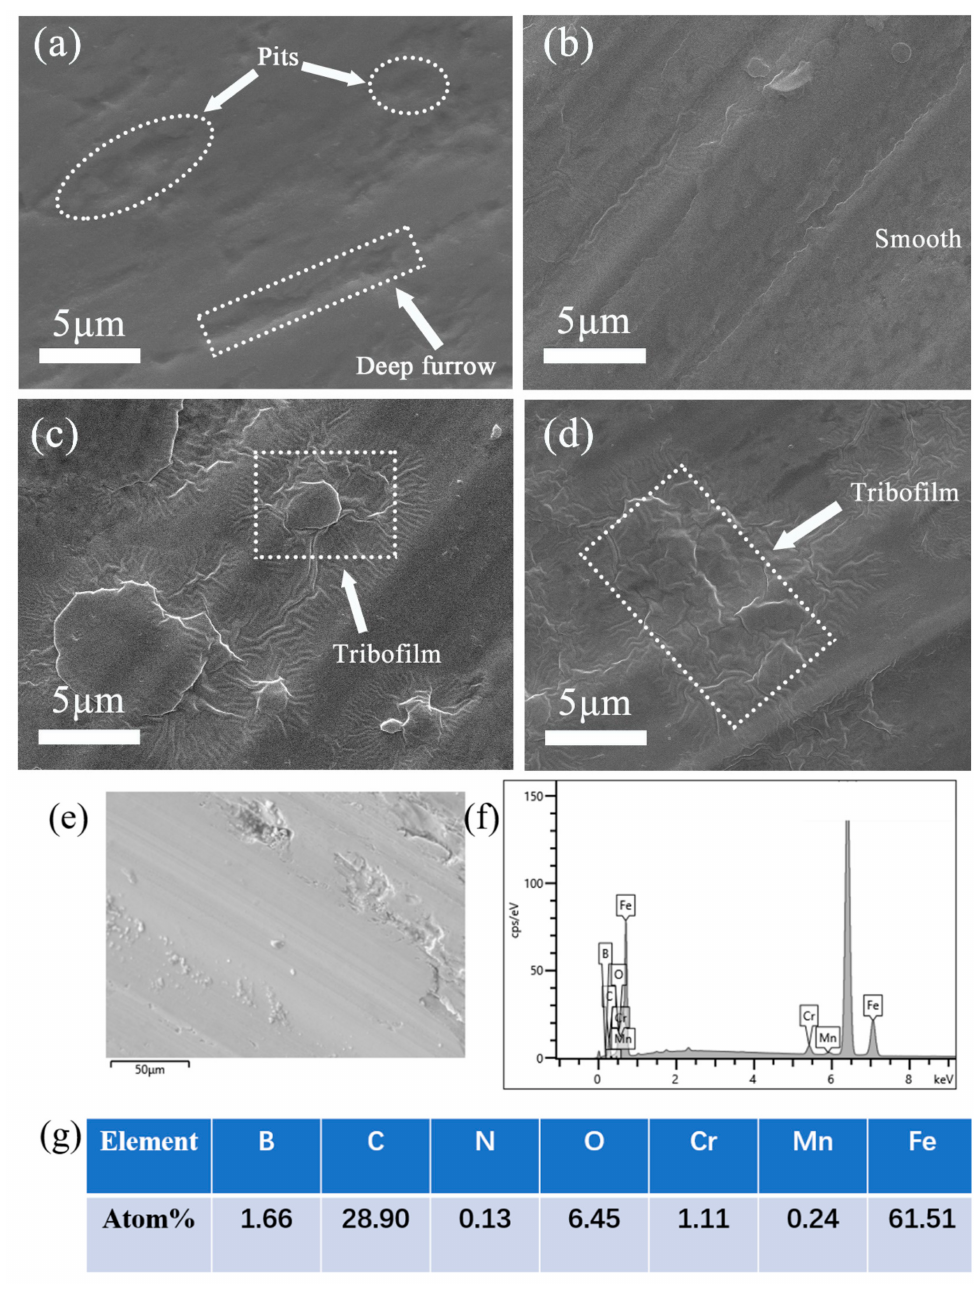
Figure 6. SEM images of the wear surface of ( a ) PAO6, ( b ) 0.1 wt%, ( c ) 0.25 wt%, and ( d ) 0.5 wt% steel balls. ( e – g ) EDS of 0.25